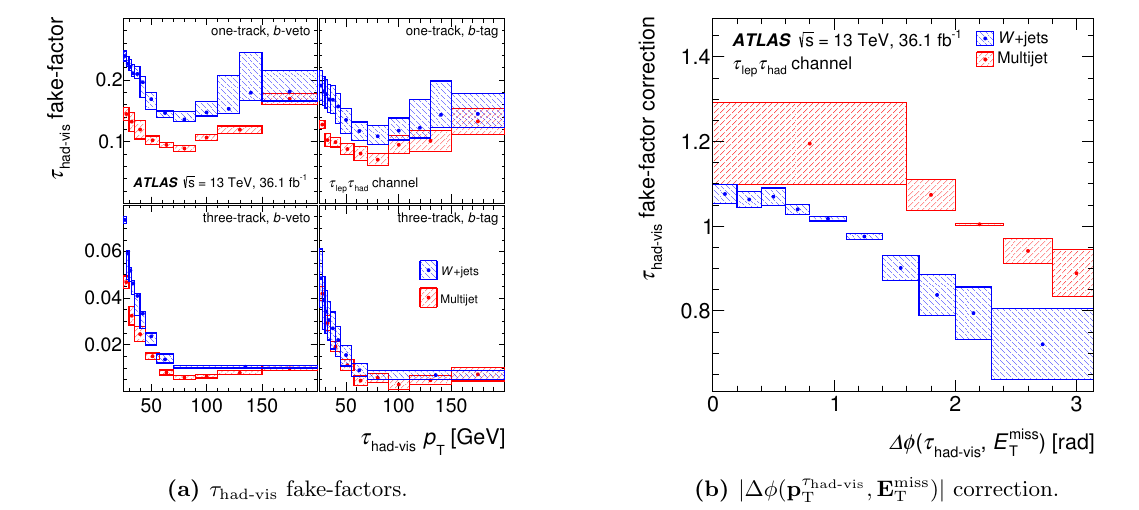
Figure 4. The (cid:28) had-vis identi(cid:12)cation fake-factors and the sequential in the (cid:28) lep (cid:28) had channel. The multijet fake-factors are for the 2016 dataset only. The bands include all